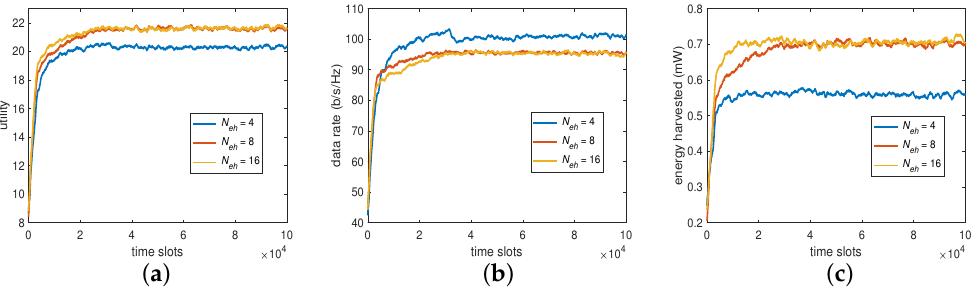
Figure 6. System performance by varying N eh : ( a ) utility, ( b ) data rate, and ( c ) harvested